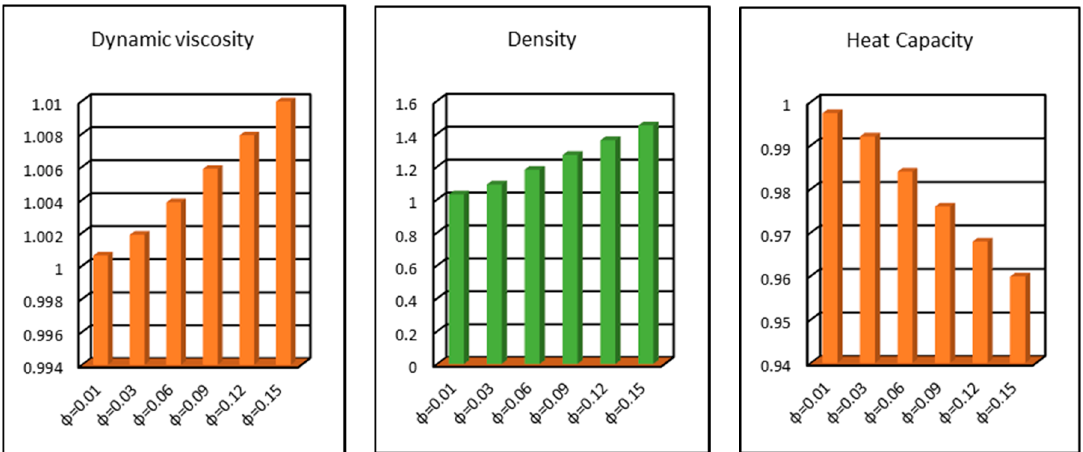
Figure 12. E ff ects of φ on e ff ective dynamic viscosity, density and heat Figure 12. Effects of ϕ on effective dynamic viscosity, density and heat capacity. Figure 12. Effects of ϕ on effective dynamic viscosity, density and heat capacity. Figure 12. Effects of ϕ on effective dynamic viscosity, density and heat capacity.